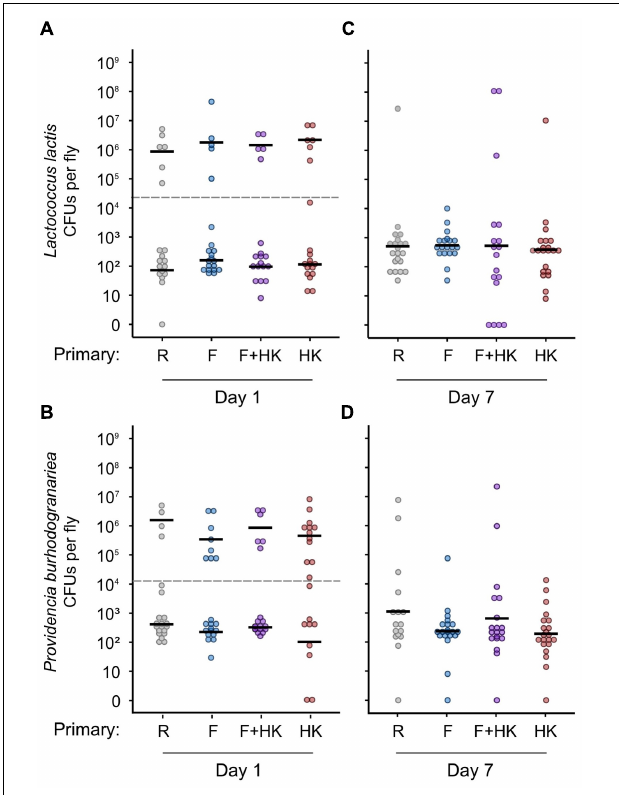
FIGURE 3 | Bacterial load of individual flies 1 and 7 days after a homologous challenge with (A,C) 92 colony forming units (CFUs) of Lactococcus lactis , or (B,D) 920 CFUs of Providencia burhodogranariea . Bacterial load on the y-axis was quantified as the number of colony-forming units per fly. Here, we present a log transformation of the CFU ( + 1) for ease of interpretation. On the x-axis, previous exposure treatments are presented as Drosophila Ringer’s solution (R), formaldehyde-inactivated bacteria (F), a mixture of formaldehyde-inactivated and heat-killed bacteria (F + HK), and heat-killed bacteria (HK). Bacterial load at day one is in the left-hand column, and the load at day seven is in the right-hand column. Black lines show the geometric mean of the bacterial load per treatment, and per subset for bacterial load 1-day post-challenge. The grey dotted lines represent the cut-off points dividing the low and high bacterial load subsets, which were analysed separately. We did not find any effect of the previous exposure on bacterial load for either of the 2 days assayed. For statistics, see Table 2 .